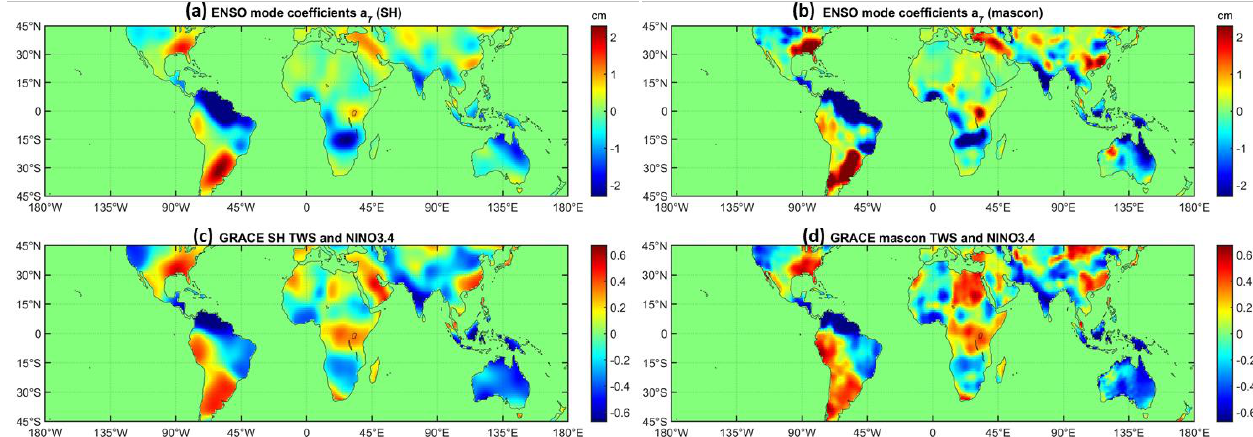
Figure 4. ENSO coefficients a 7 of least squares fitting and zero-phase-lag cross correlation coefficients between interannual TWS changes and Niño 3.4 index. ( a , b ) show ENSO coefficients a 7 obtained from GRACE SH and mascon solutions, respectively; ( c ) shows correlation coefficients between TWS changes from GRACE SH solutions and Niño 3.4 index; and ( d ) shows the cross-correlation coefficients between TWS changes from GRACE mascon solutions and Niño 3.4 index.